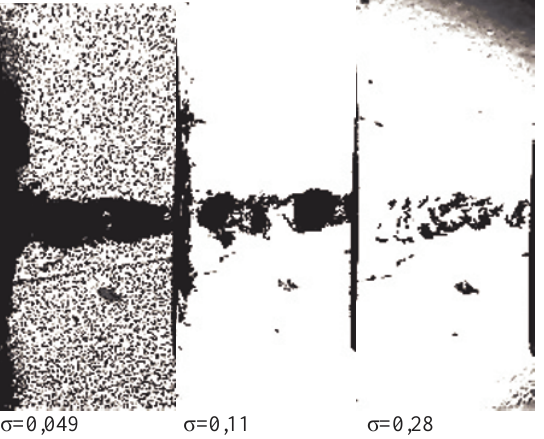
Fig. 7. The form of a cavitating jet (flow from right to left).